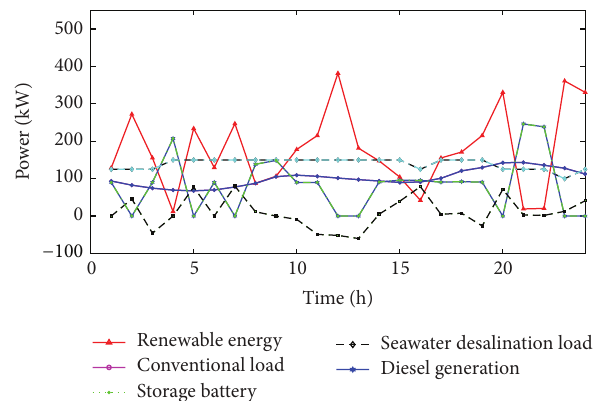
Figure11:Theoutputresultsofthevariousmicrosourcesin24hours without auxiliary power regulation at the least total loss expenses conditions.